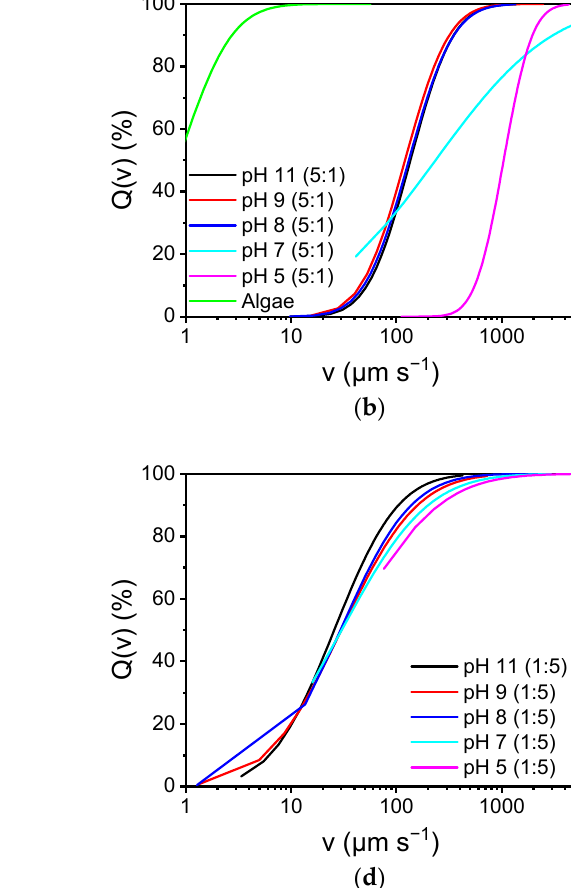
sible. The higher pH values (10 and 11) showed the best separation properties.